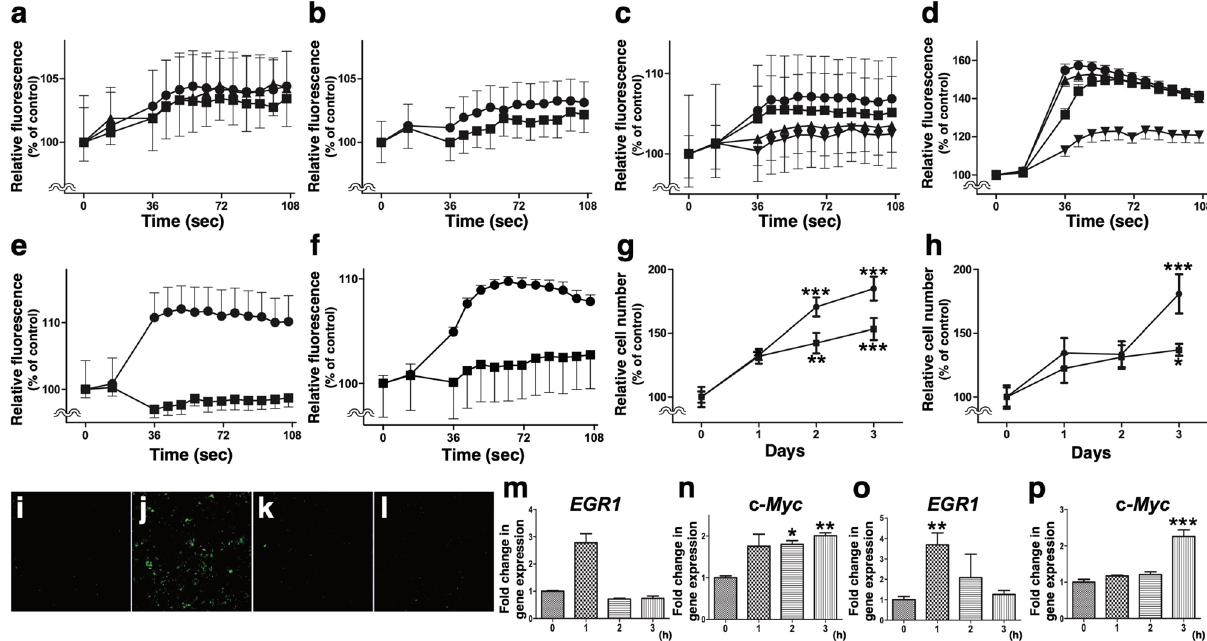
Figure 3. Intracellular responses of vascular smooth muscle cells to SBSN_HUMAN[225–237] and SBSN_HUMAN[243–259]. ( a – f ) Effect of SBSN_HUMAN[225–237] and SBSN_HUMAN[243–259] on [Ca 2+ ] i . A10 cells ( a , c ) and HAoSMCs ( b , d ) were stimulated with either SBSN_HUMAN[225–237] ( a , b ) or SBSN_HUMAN[243–259] ( c , d ) (closed circle: 10 –6 M; closed square: 10 –7 M, closed triangle: 10 –8 M, closed inverted triangle: 10 –9 M) and Fluo-4/AM fluorescence intensities were monitored. A10 cells ( e ) and HAoSMCs ( f ), pretreated without (closed circle) or with 10 –5 M nicardipine (closed square), were stimulated with SBSN_HUMAN[243–259]. ( g , h ). Data represent the mean ± S.E.M of octuple assays. ( g , h ) Effect of SBSN_HUMAN[225–237] ( g ) or SBSN_HUMAN[243–259] ( h ) on A10 cell proliferation (closed circle: 10 –6 M, closed square:10 –7 M). * p < 0.05, ** p < 0.01, *** p < 0.01 compared with day 0. Data represent the mean ± S.E.M